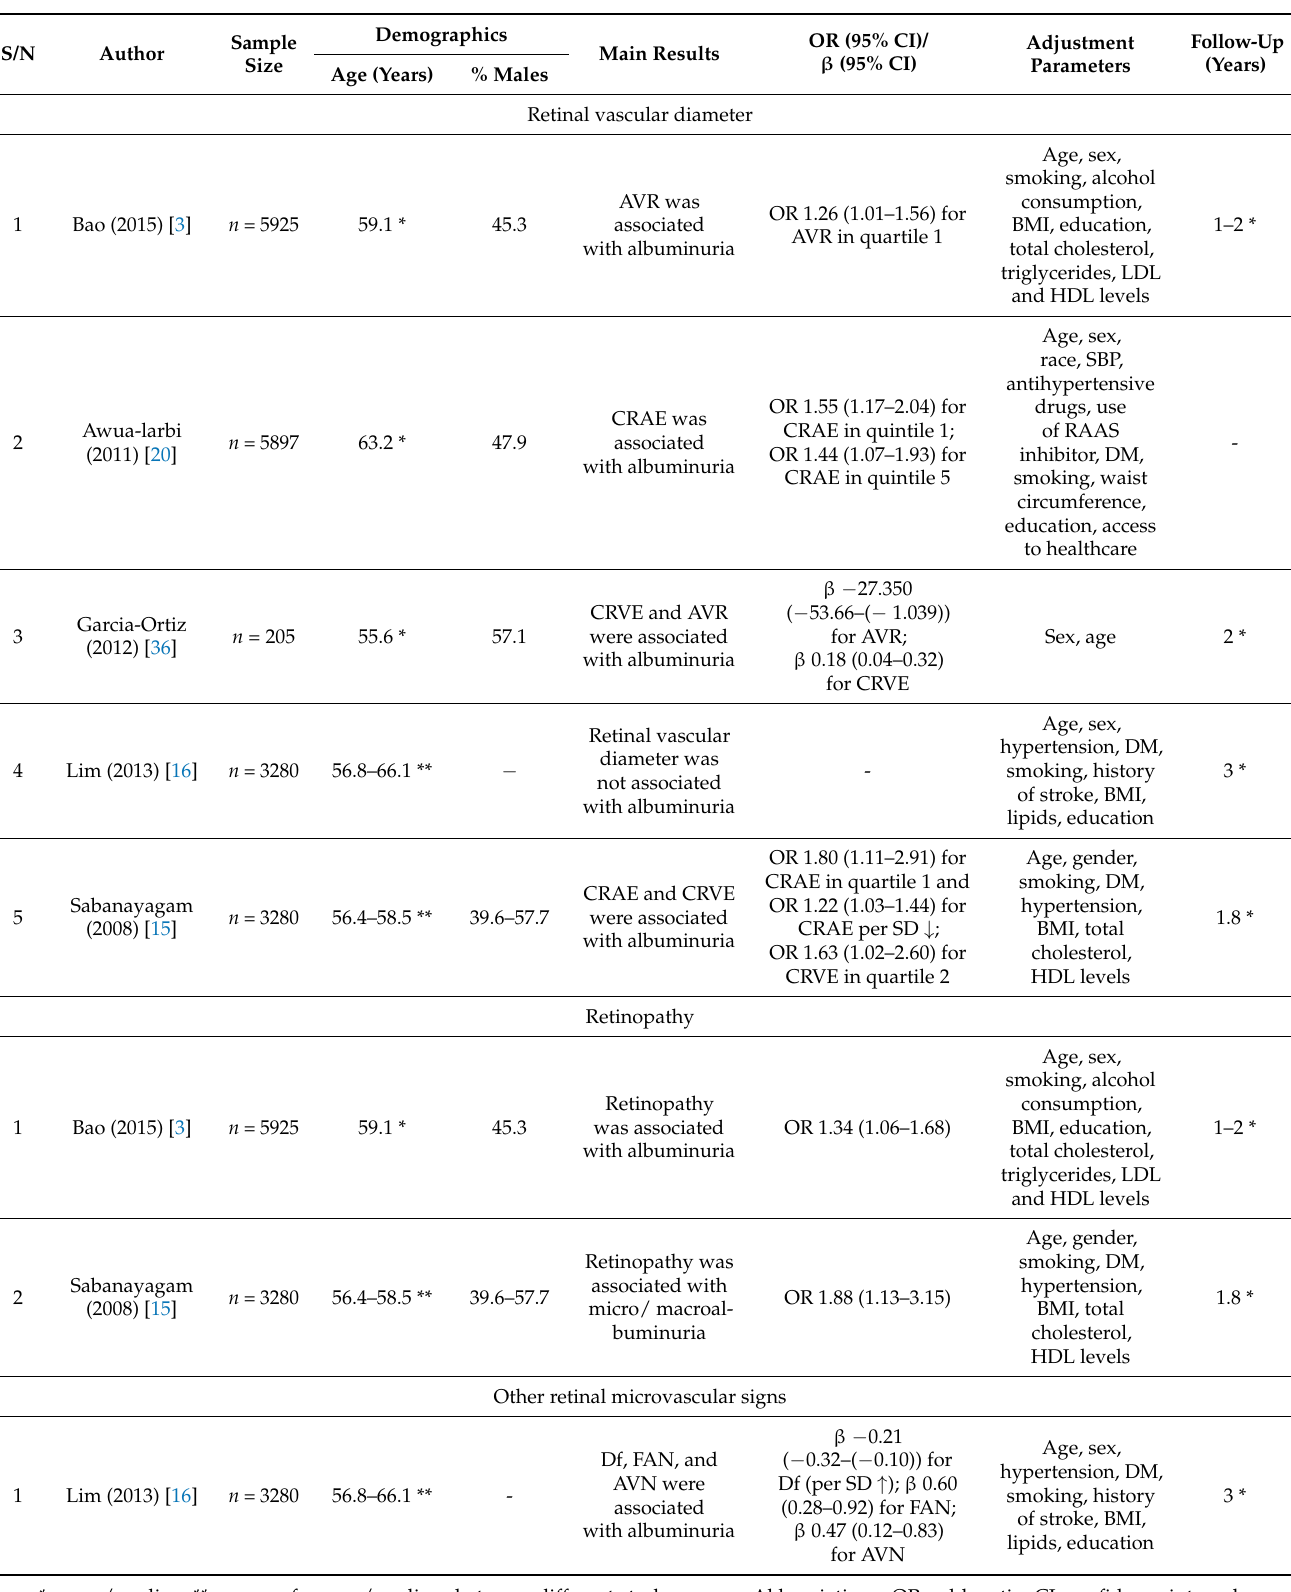
Table 6. Retinal microvascular signs and